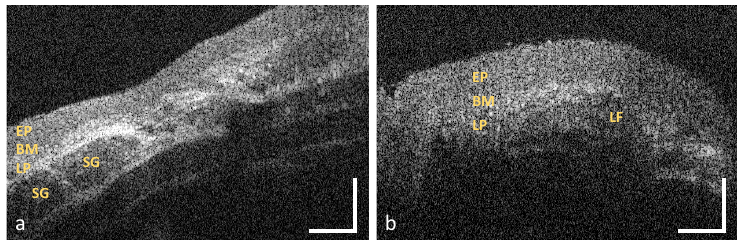
Figure 3. Exemplary OCT images of the oropharynx ( a ) and the palatine tonsil ( b ). The connective tissue of the oropharynx contains minor salivary glands whereas the palatine tonsil includes multiple lymphoid follicles. EP:epithelium, BM:basement membrane, LP:lamina propria, SG:salivary gland, LF:lymphoid follicle. Scalebar:200 µ